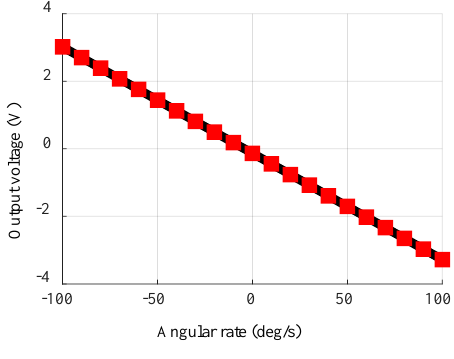
Figure 13. Scale factor curve.